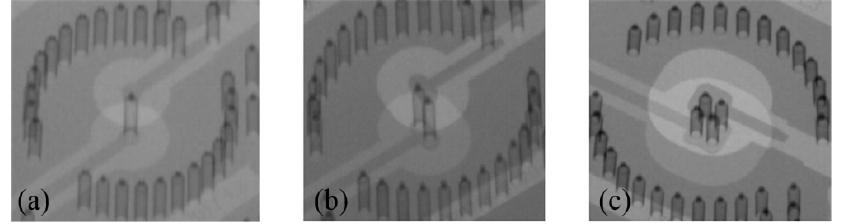
Figure 10. Test structure X-ray detection map: ( a ) single TSV; ( b ) dual redundant TSV; ( c ) quad redundant TSV.